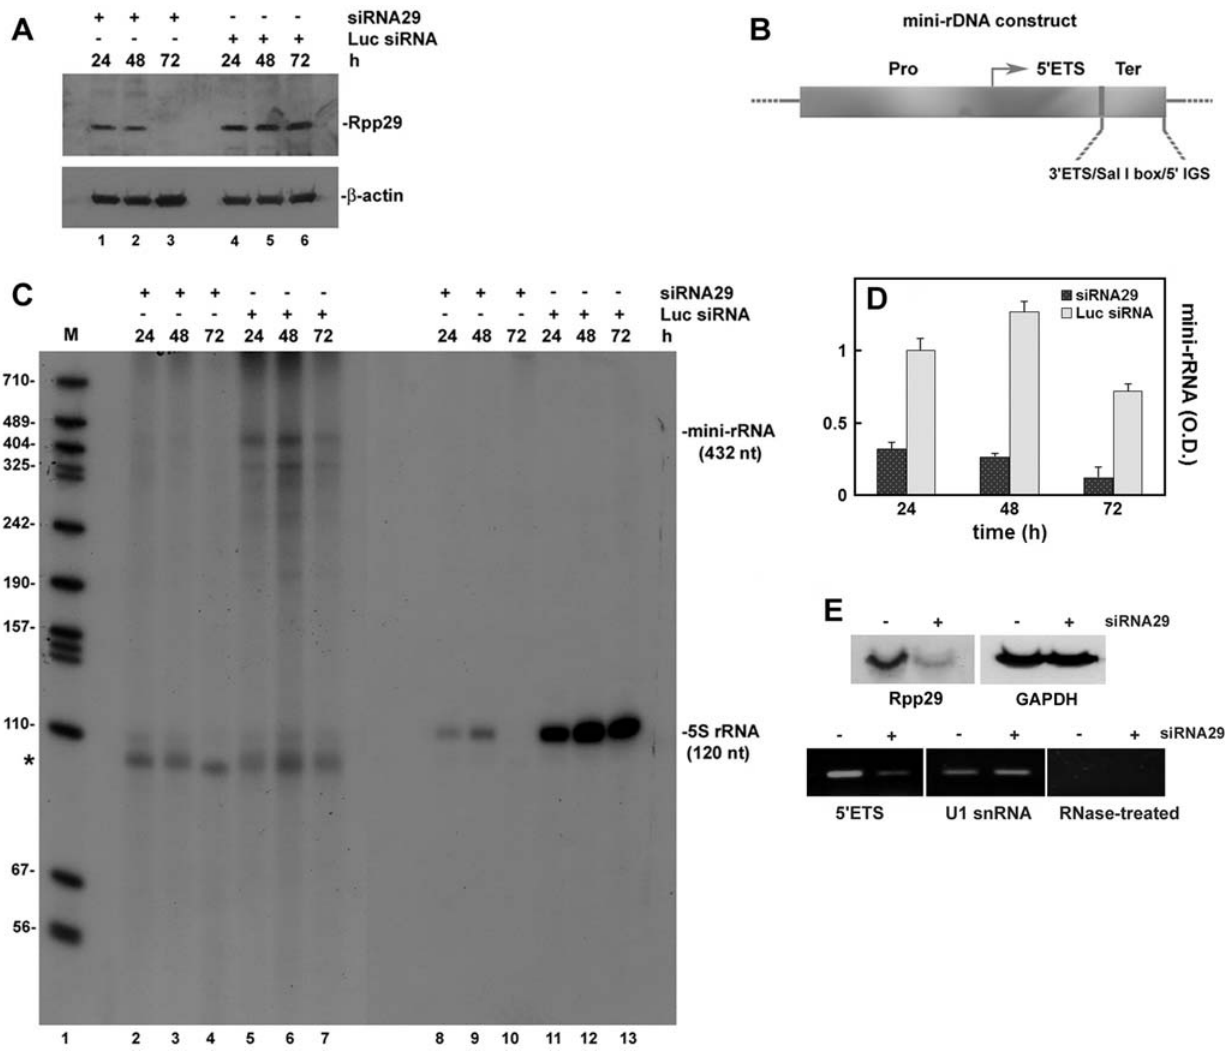
Figure 1. Knockdown of Rpp29 by siRNA causes inhibition of Pol I transcription. A. HeLa cells were transfected with siRNA29 or luciferase siRNA (see Materials and Methods), whole extracts were then prepared from cells at 24, 48 and 72 h after transfection and examined by Western blot analysis for Rpp29 and b -actin. Positions of proteins are depicted. B. A scheme of the human mini-rDNA gene. This construct has a rDNA gene promoter (from position 2 500) and 5 9 ETS (position + 382) that was subcloned in pBluescript in which a rDNA terminator region, consisting of 57-bp 3 9 ETS, Sal I box and 51-bp IGS, was inserted. The 5 9 ETS is 382 bp in length and harbors no known cleavage site, including the A 9 site. Arrow points to the transcription initiation site. C. Transcription of the mini-rRNA and 5S rRNA genes in extracts described in A. Labeled RNA was separated in 8% polyacrylamide/7 M urea gel and subjected to autoradiography. Lanes 1–7 represent exposure for longer time than that of lanes 8–13. Positions of the 432-nt mini-rRNA (lanes 2–7) and 120-nt 5S rRNA (lanes 8–13) transcripts are shown. Asterisk represents endogenous but unknown labeled RNA. D. The optical density (in arbitrary units) of the mini-rRNA band seen in lanes 2–7 of panel C. E. HeLa cells were treated with siRNA29 or luciferase siRNA for 48 h and knockdown of Rpp29 was tested by Western blot analysis (left panel). GAPDH was used as internal control. Total RNA was extracted from cells and subjected to RT-PCR analysis of 5 9 ETS and U1 snRNA (see Materials and Methods). As negative control, RNA was treated with RNase A before reverse transcription of the 5 9 ETS (right panel). PCR products were separated in agarose